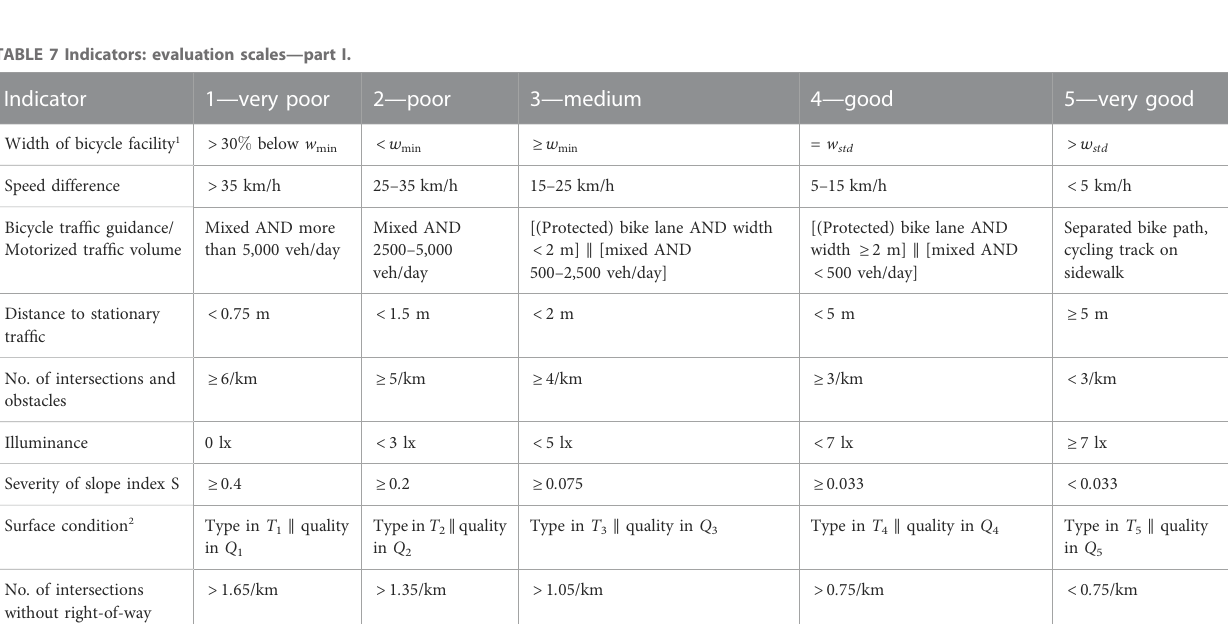
TABLE 7 Indicators: evaluation scales — part I.